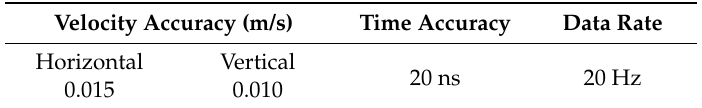
Table 5. The main parameters of the SINS/GNSS integrated navigation system.